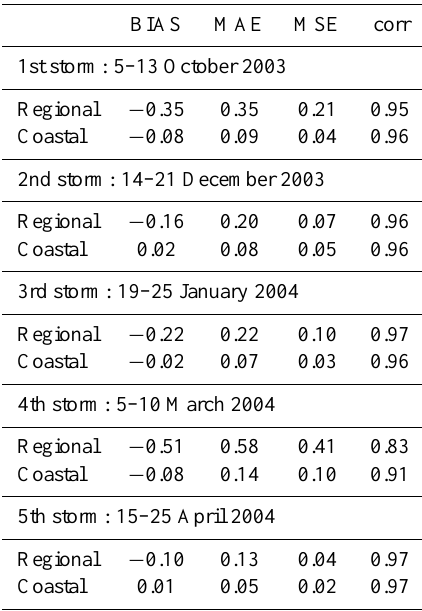
Fig. 14. Scatter diagram of recorded vs. SWAN H s at Tropea. The The storms considered in the analysis are listed in Table 3. 8 storms considered in the analysis are listed in Tab.3